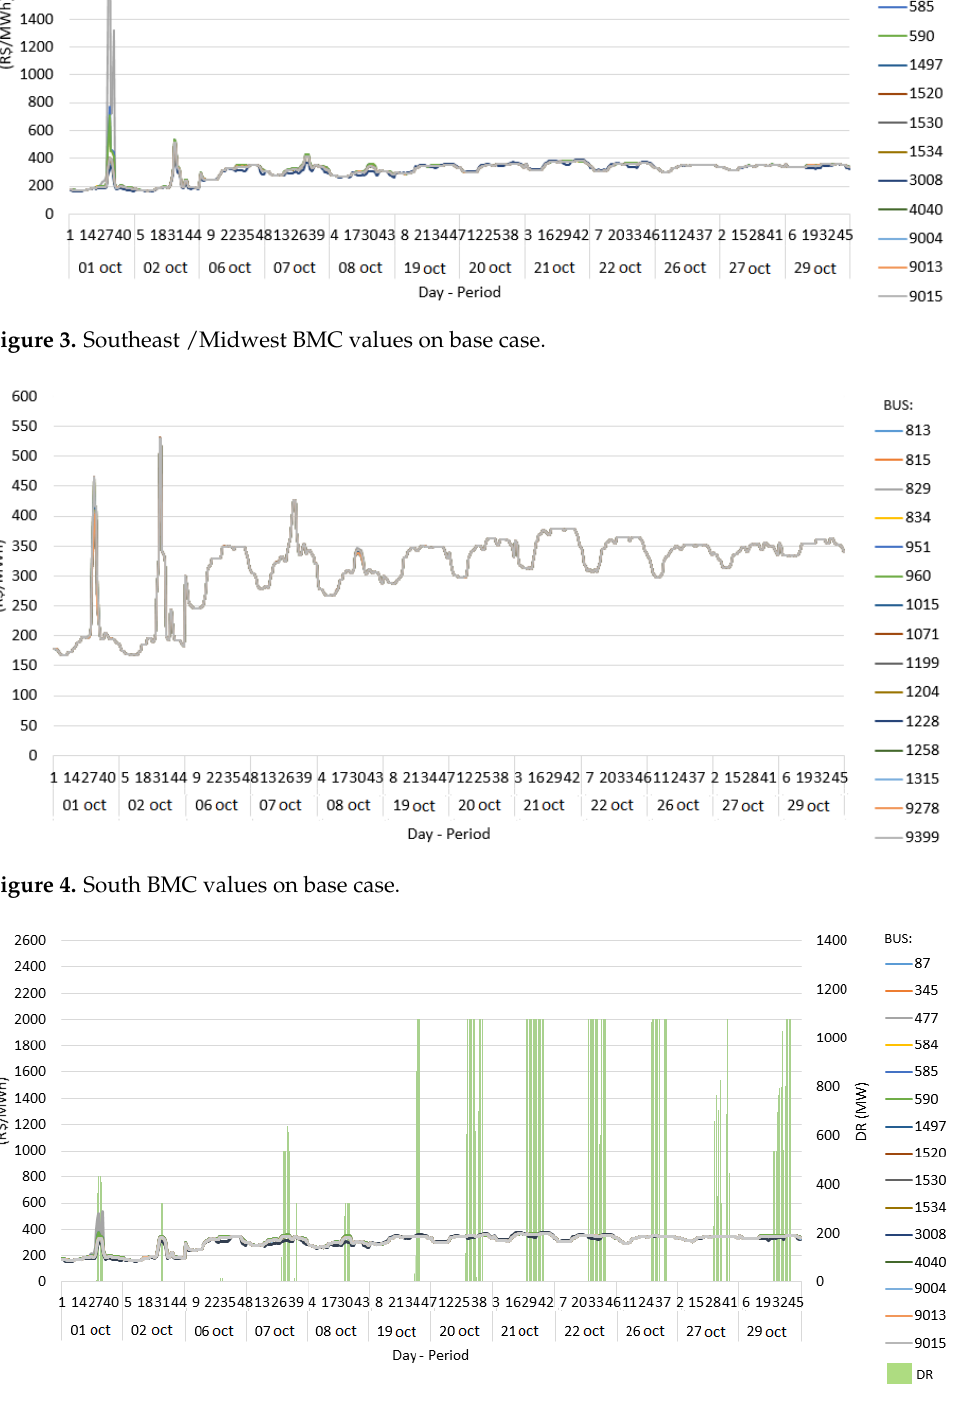
Figure 5. Southeast/Midwest BMC values and related buses with DR